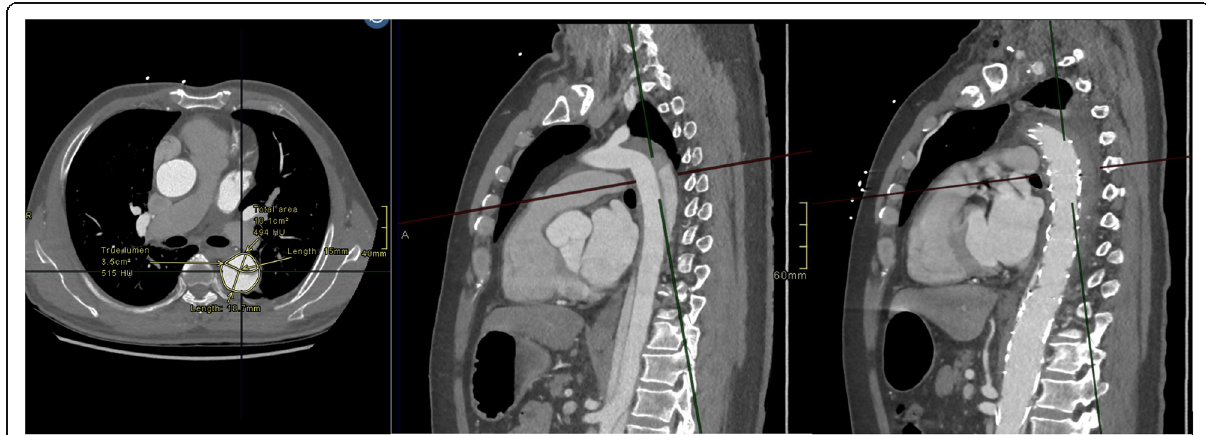
Fig. 1 MPR at the level of the carina with selected fluoroscopic images showing obliteration of the false lumen at the level of the arch/